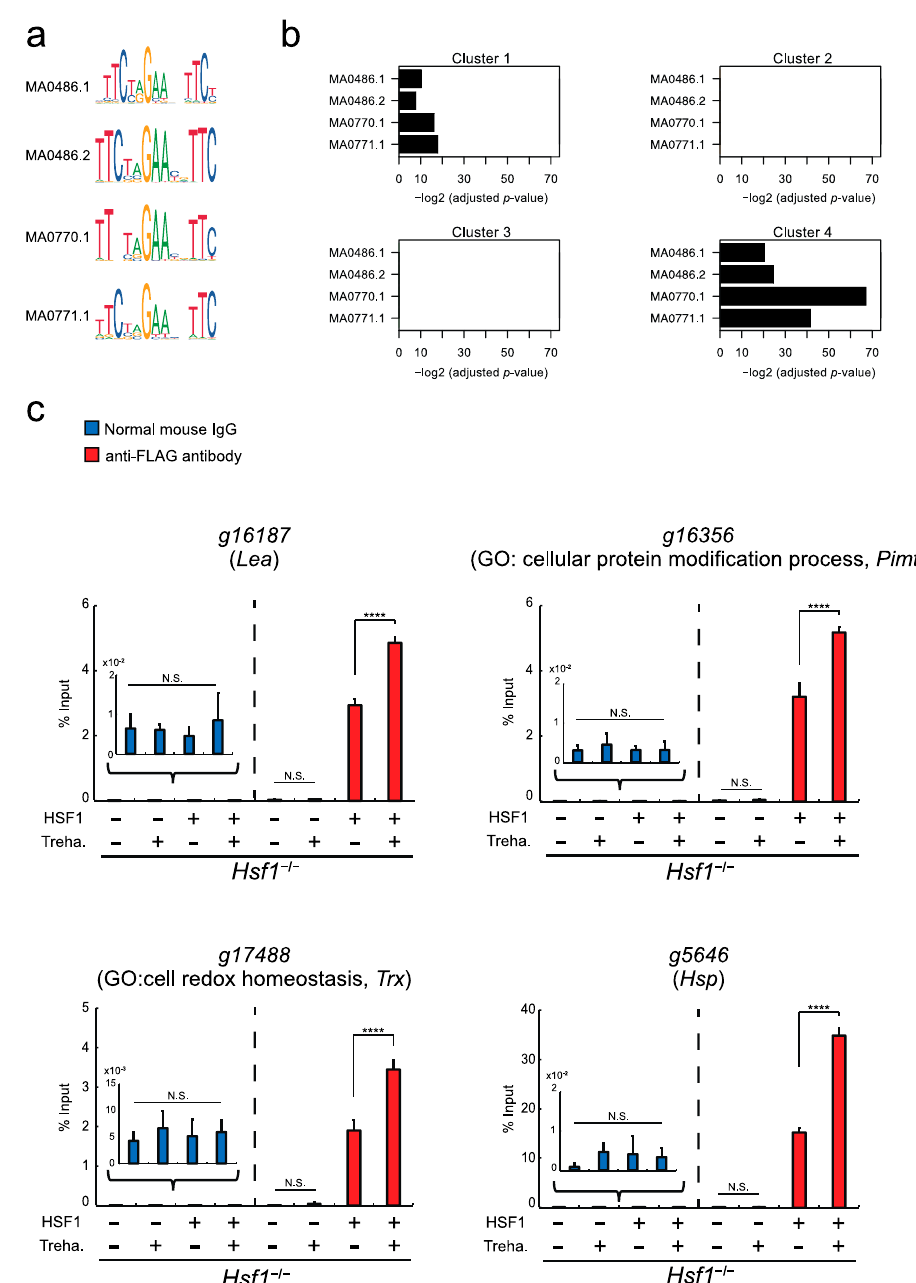
Figure 4. Heat shock element (HSE) enrichment analysis in gene promoters and confirmation of HSF1 binding: ( a ) HSF binding sequences that are registered as HSEs in the JASPAR2018 CORE database; ( b ) HSE enrichment analysis in each cluster of Figure 3a. It is predicted that HSEs are most enriched in the promoter regions of cluster 4 genes, as defined in Figure 3a; ( c ) ChIP assay of HSF1 binding to the promoters of four cluster 4 genes, performed on Hsf1 − / − ; HaloTag/BlaR and Hsf1 − / − ; Hsf1 -HaloTag/BlaR cell lines. FLAG antibody was used to immunoprecipitate HSF1-FLAG/DNA complexes, and normal mouse IgG was used as a negative control. Normalized values are expressed as mean ± SD. Treha. − , before trehalose treatment (T0); Treha. (+), after trehalose treatment (T48); HSF1 ( − ); Hsf1 − / − ; HaloTag/BlaR; HSF1+, Hsf1 − / − ; Hsf1 -HaloTag/BlaR; **** p < 0.0001; N.S., not significant; n = 3 in each group.